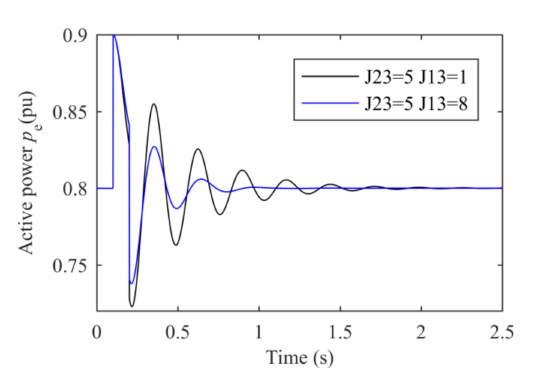
Figure 7. Effects of structure factor J 13 on the